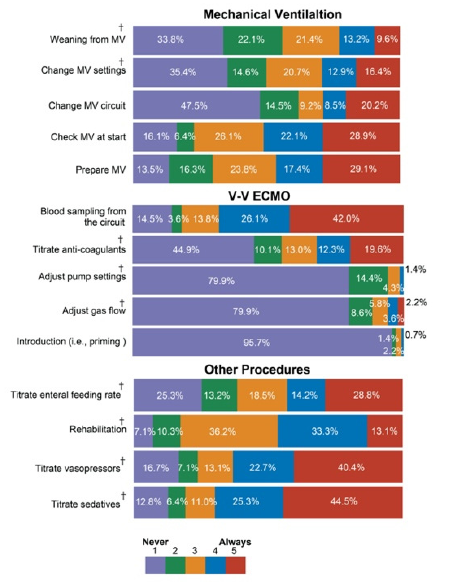
Figure 2. Nursing activities for specific procedures.Note: “Always” means that the nurse always undertook the procedure. “Never” means that the nurse never undertook the procedure and that other professionals, such as physicians, undertook the task. Missing data were included in this analysis. Abbreviations: MV, mechanical ventilator; VV-ECMO, veno-venous extracorporeal membrane oxygenation; † under a pre-prescribed